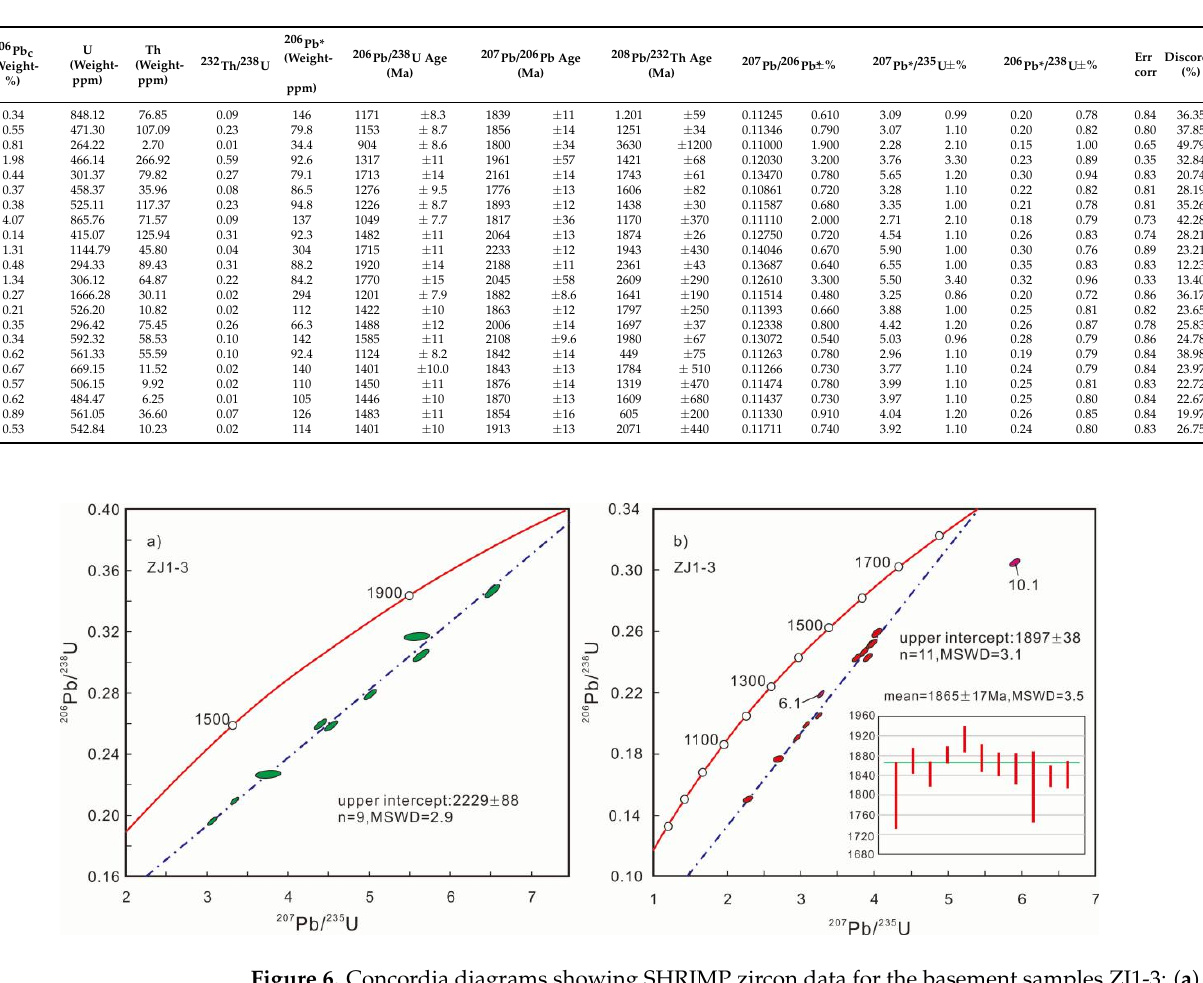
Table 1. SHRIMP U-Pb analyses of zircons for granitic gneiss sample ZJ1-3 from drill cores ZJ-1 at northeastern Ordos Basin.